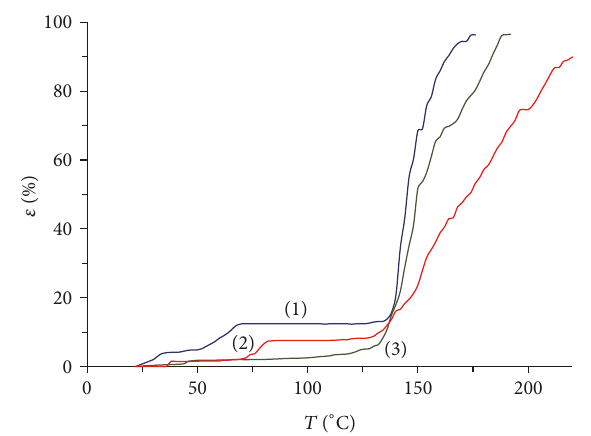
Figure 9: Thermomechanical curves of materials based on MMA- PVP-gr-PMMA compositions: (1) , (3) not heat-treated, (2) heat- treated at 333 K; (3) with SiO 2 . Filler content: